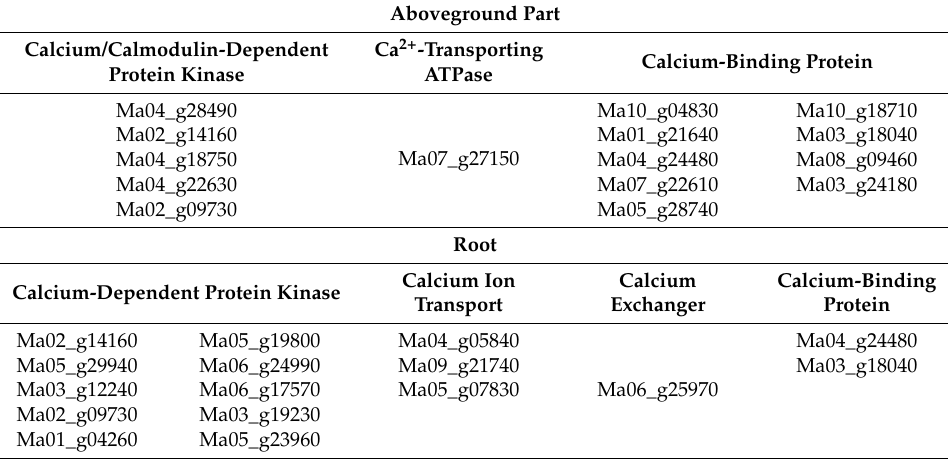
Table 3. Ca 2+ signal